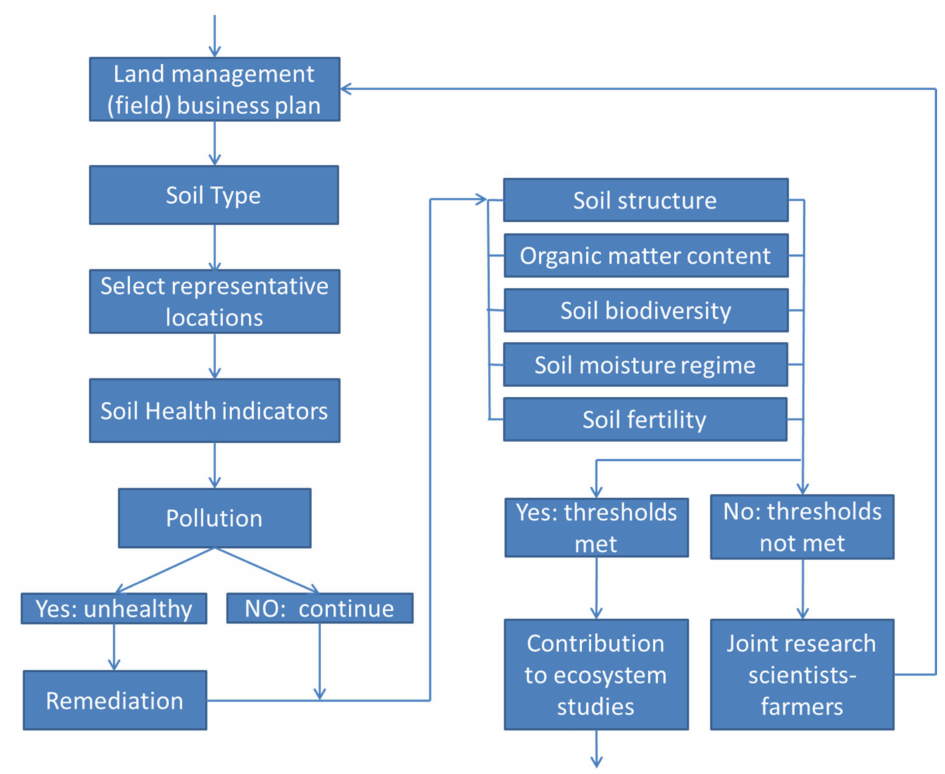
Figure 2. Flow chart demonstrating the procedure to test whether soils are healthy with the objective of maximizing soil contributions to ecosystem services (see